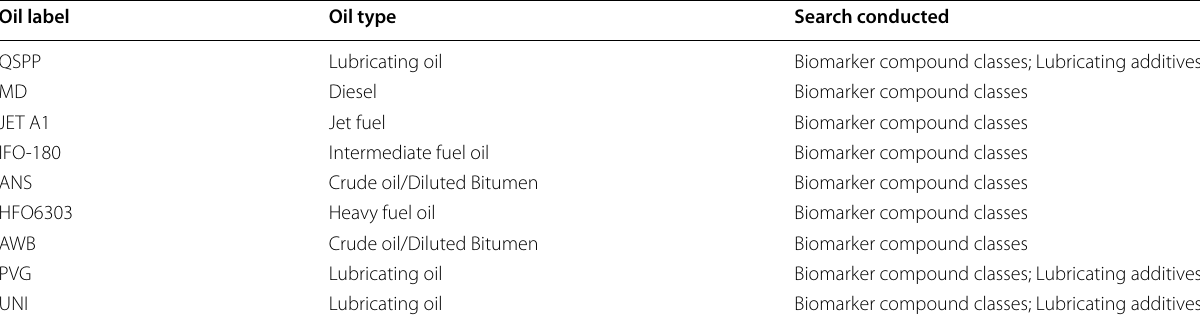
Table 1 Oils selected for exploratory search of biomarker compound classes and lubricant additives Oil